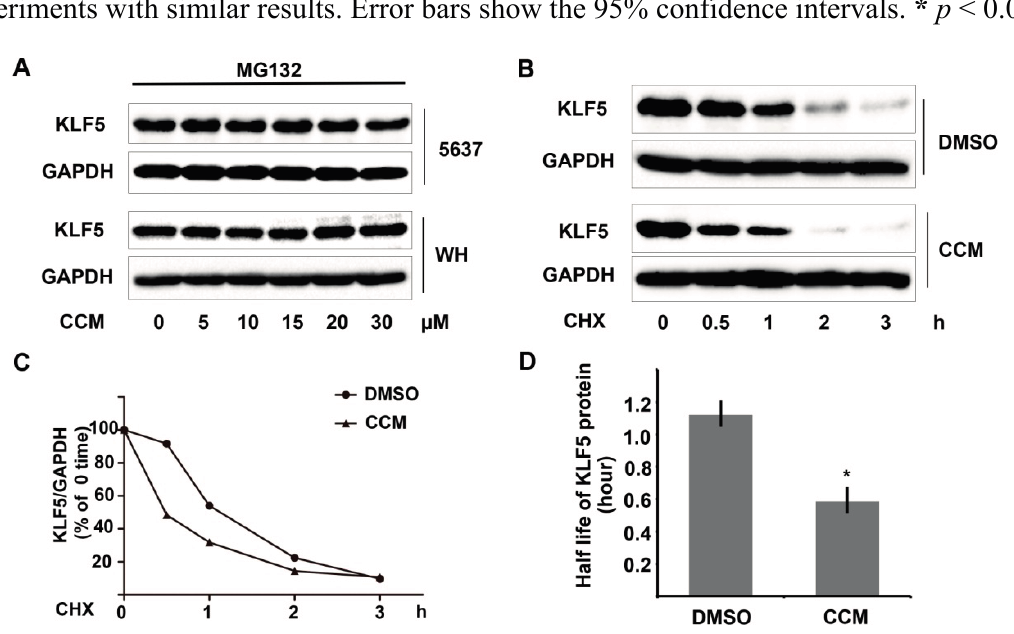
Figure 2. Curcumin promoted proteasome-dependent degradation of KLF5 protein. ( A ) 5637 and WH cells were pretreated with 10 μ M MG132 for one hour before the treatment of curcumin. Twelve hours later, the whole-cell lysates were harvested, and KLF5 protein was analyzed by western blot; ( B ) KLF5 protein attenuation in the cycloheximide (CHX) chase assay was examined after DMSO or curcumin treatment in 5637 cells; ( C ) KLF5 protein levels were quantified using Image Lab software and were normalized to GAPDH; and ( D ) KLF5 half-life values were calculated by nonlinear regression analysis with GraphPad Prism software. The results represent three independent experiments with similar results. Error bars show the 95% confidence intervals. * p <